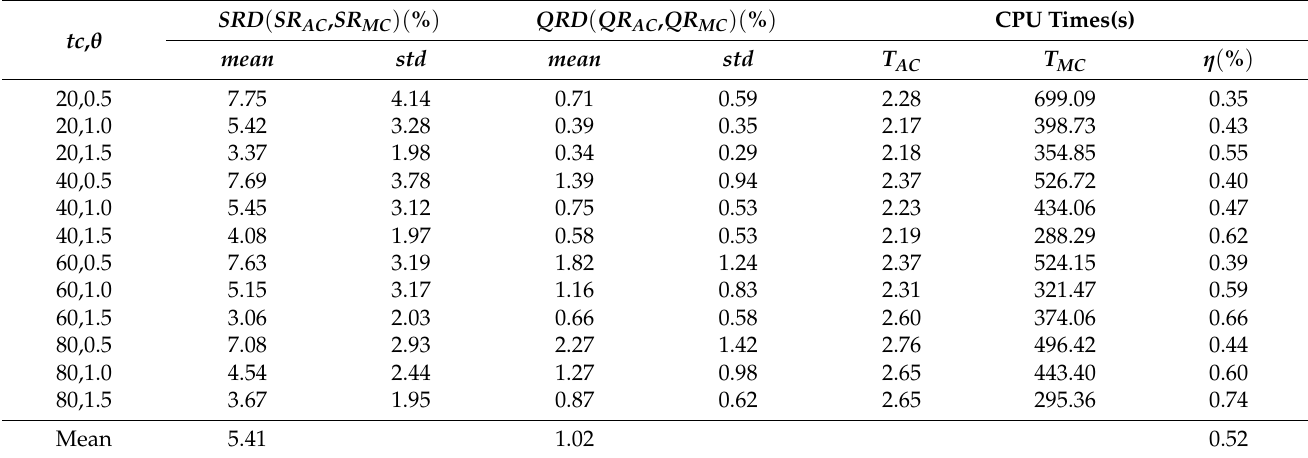
Table 2. Evaluate the performance of M AC .